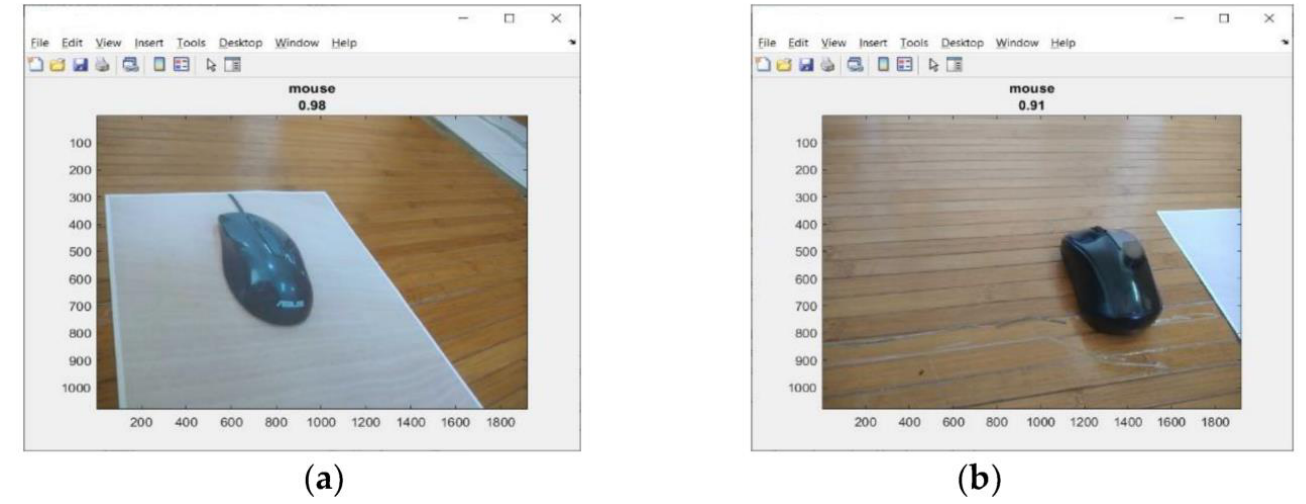
Figure 2. A sample of the detection object (mouse). ( a ) A photo of a mouse on paper (2D); ( b ) a real mouse photo (3D).